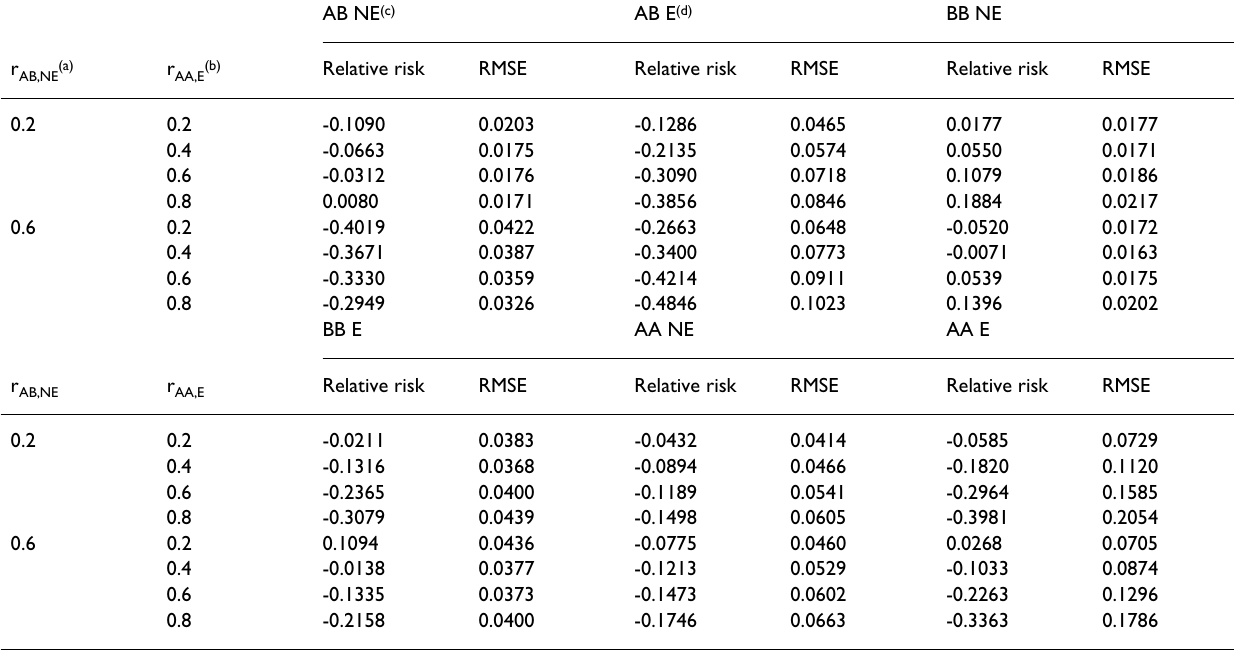
Table 5: Relative bias and RMSE of the disease risks predicted using the reduced model in the third scenario.